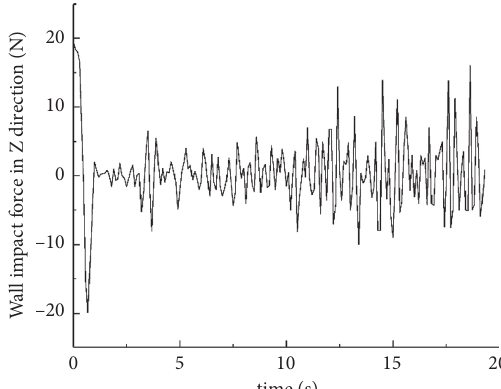
Figure 5: Impact force on the spray tank wall surface in Z direction.